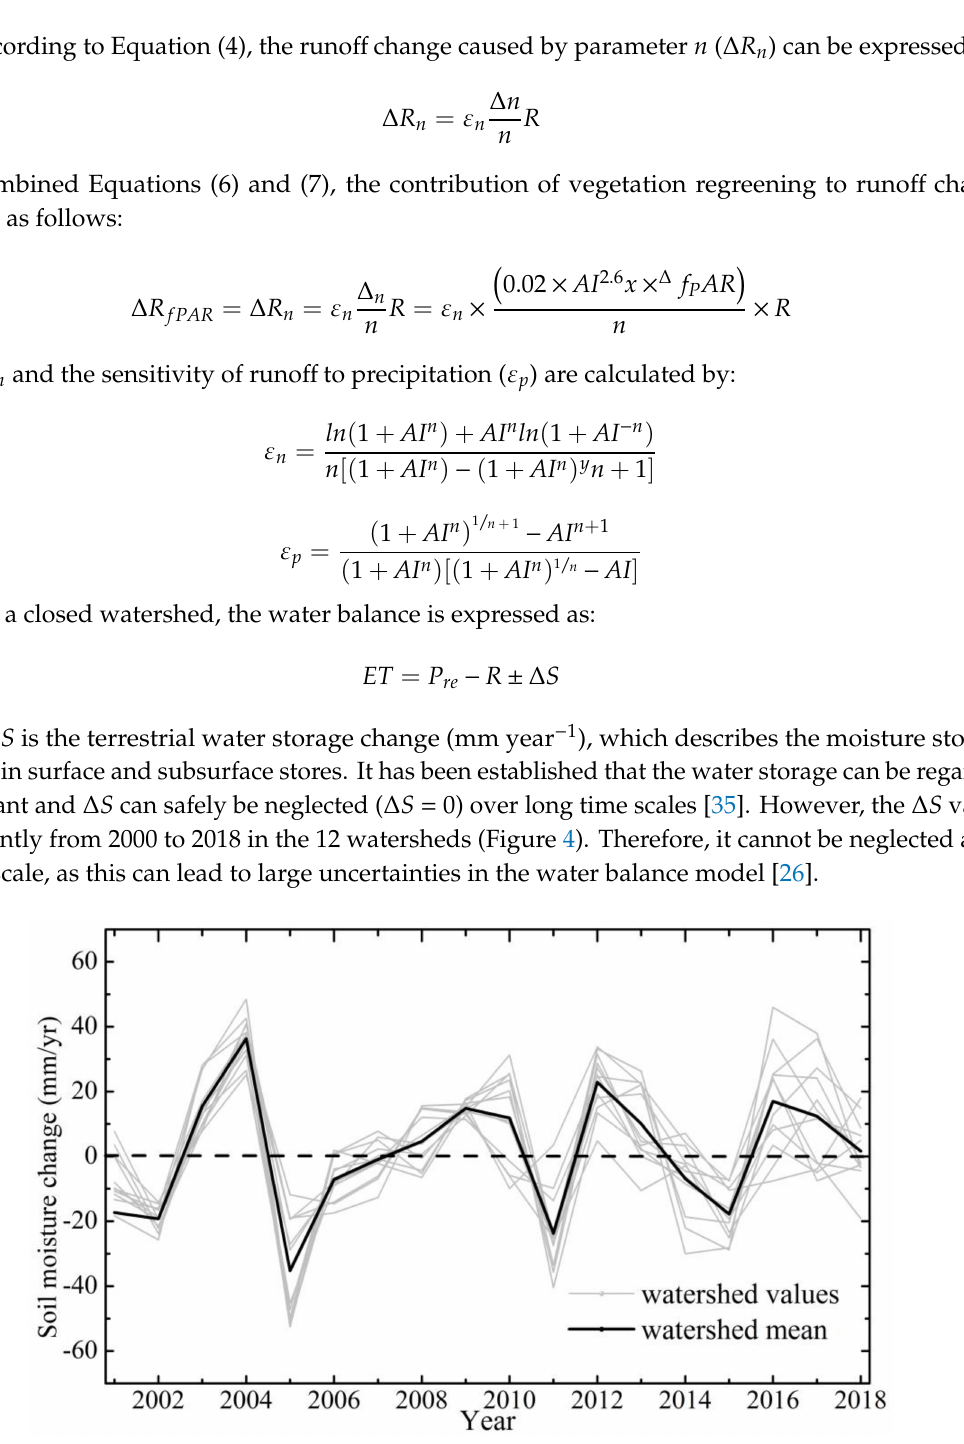
Figure 4. Soil moisture content changes at the depth of 2 m in the 12 middle Yellow River watersheds. The thin black lines show the 12 watershed values; the dark black line is the mean